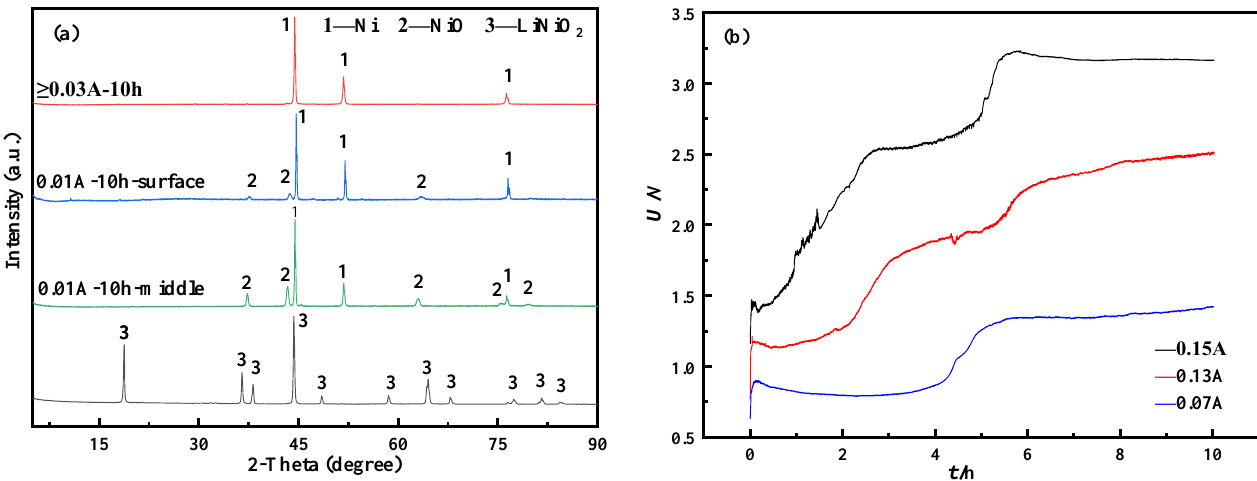
Figure 14. ( a ) XRD patterns of the product after 10 h electrolysis under different current conditions ( b ) U-t diagram of electrolysis at 750 °C for 10 h at 0.07–0.15 A.